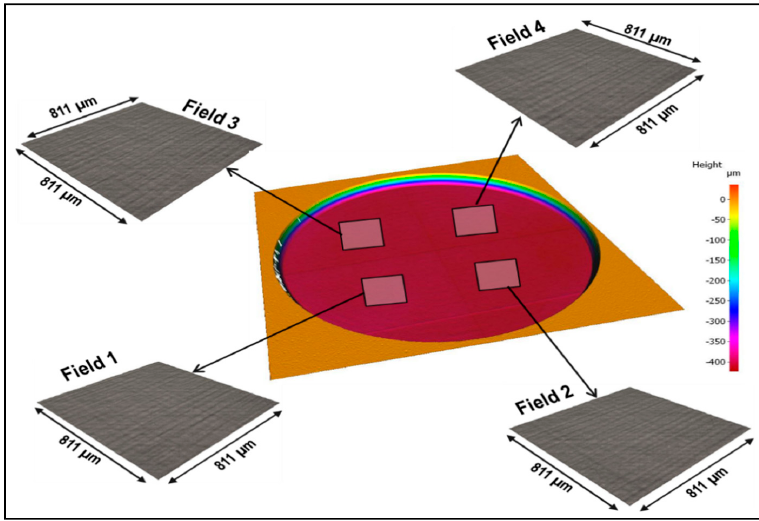
Figure 8. Laser micromachining results obtained with the optimised laser parameter settings to fabricate a 7-mm diameter circular recess with a depth of 400 µ m.